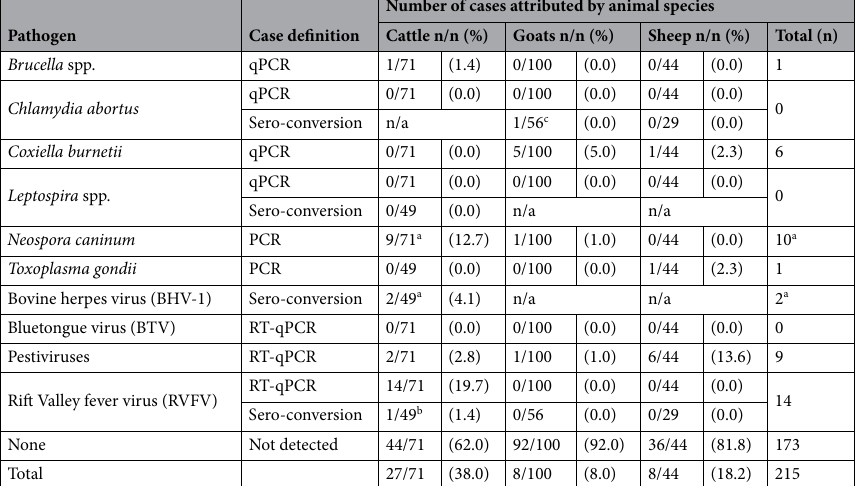
Pathogen Case definition